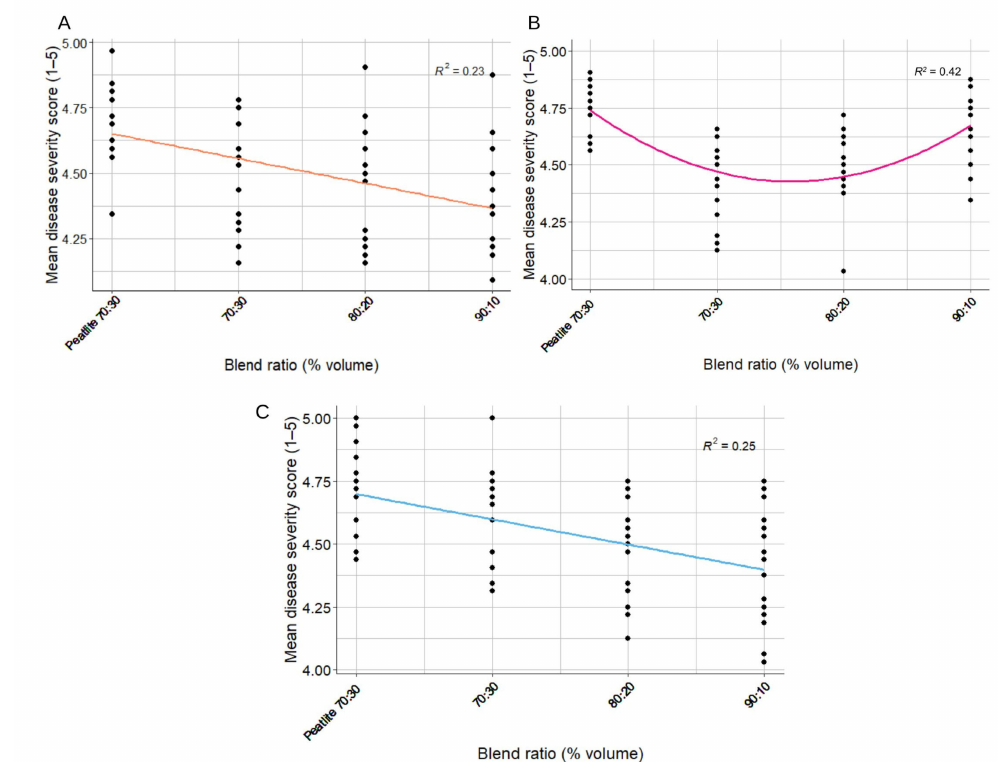
Figure 1. Scatter plots representing the effect of peat:wood blend ratio on mean disease severity of R. solani seven days post-infestation for ( A ) disc-refined Forest Gold (FG), ( B ) extruded GreenFibre (GF), and ( C ) hammer-milled pine tree substrate (PTS). Wood treatments were tested in separate experiments, each with a 70:30 peat:perlite control. For disc-refined FG and hammer-milled PTS, a linear regression line was the best fit (R 2 = 0.23; R 2 = 0.25 respectively). For extruded GF, a quadratic regression line was the best fit (R 2 =